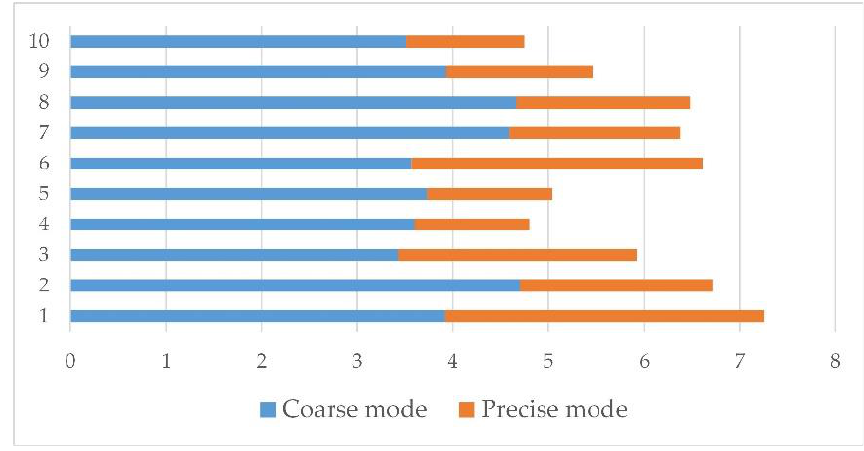
Figure 10. Proportion of each mode of double-precision pointing technology.